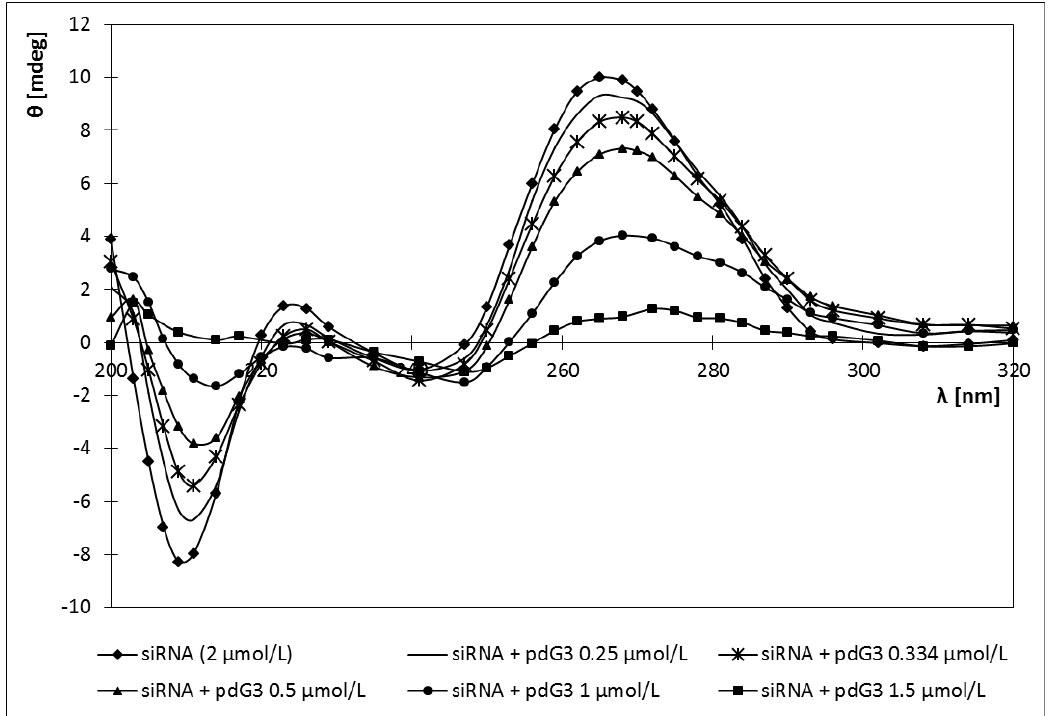
Figure 7. CD spectra of siRNA in the presence of different concentrations of phosphorus dendrimers generation 3 (pdG3) [siRNA] = 2 µmol/L.